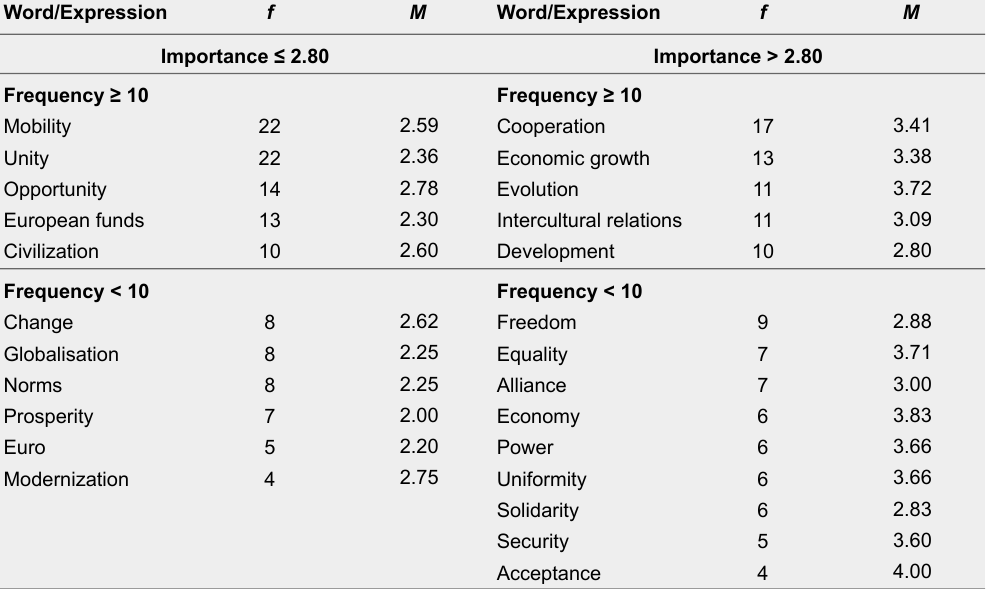
Mf Word/Expression Mf